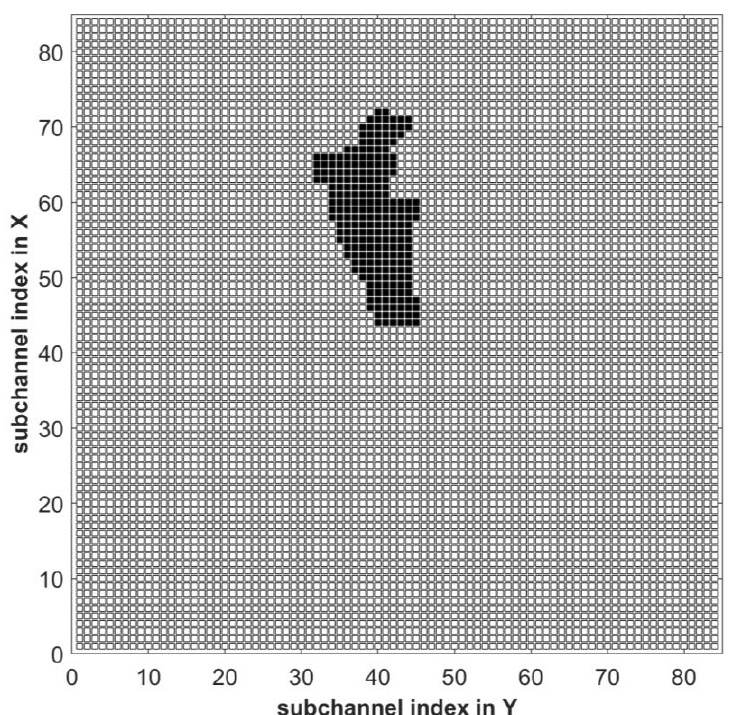
Fig. 6. The example of suppression mask. The subchannels of marks which will be suppressed at the next scan are shown black.